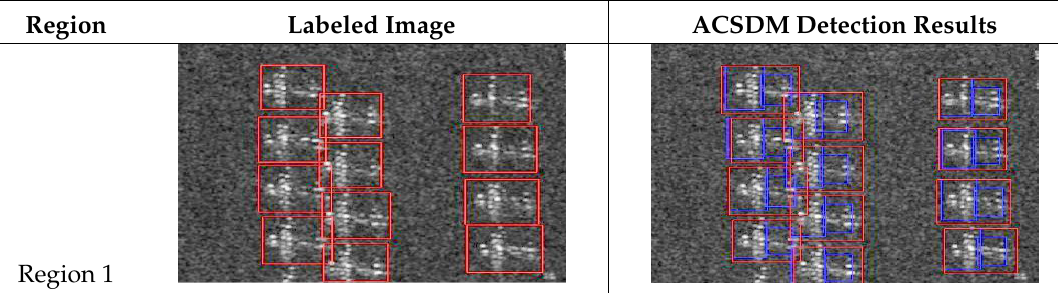
Table 3. Experimental results of the ACSDM